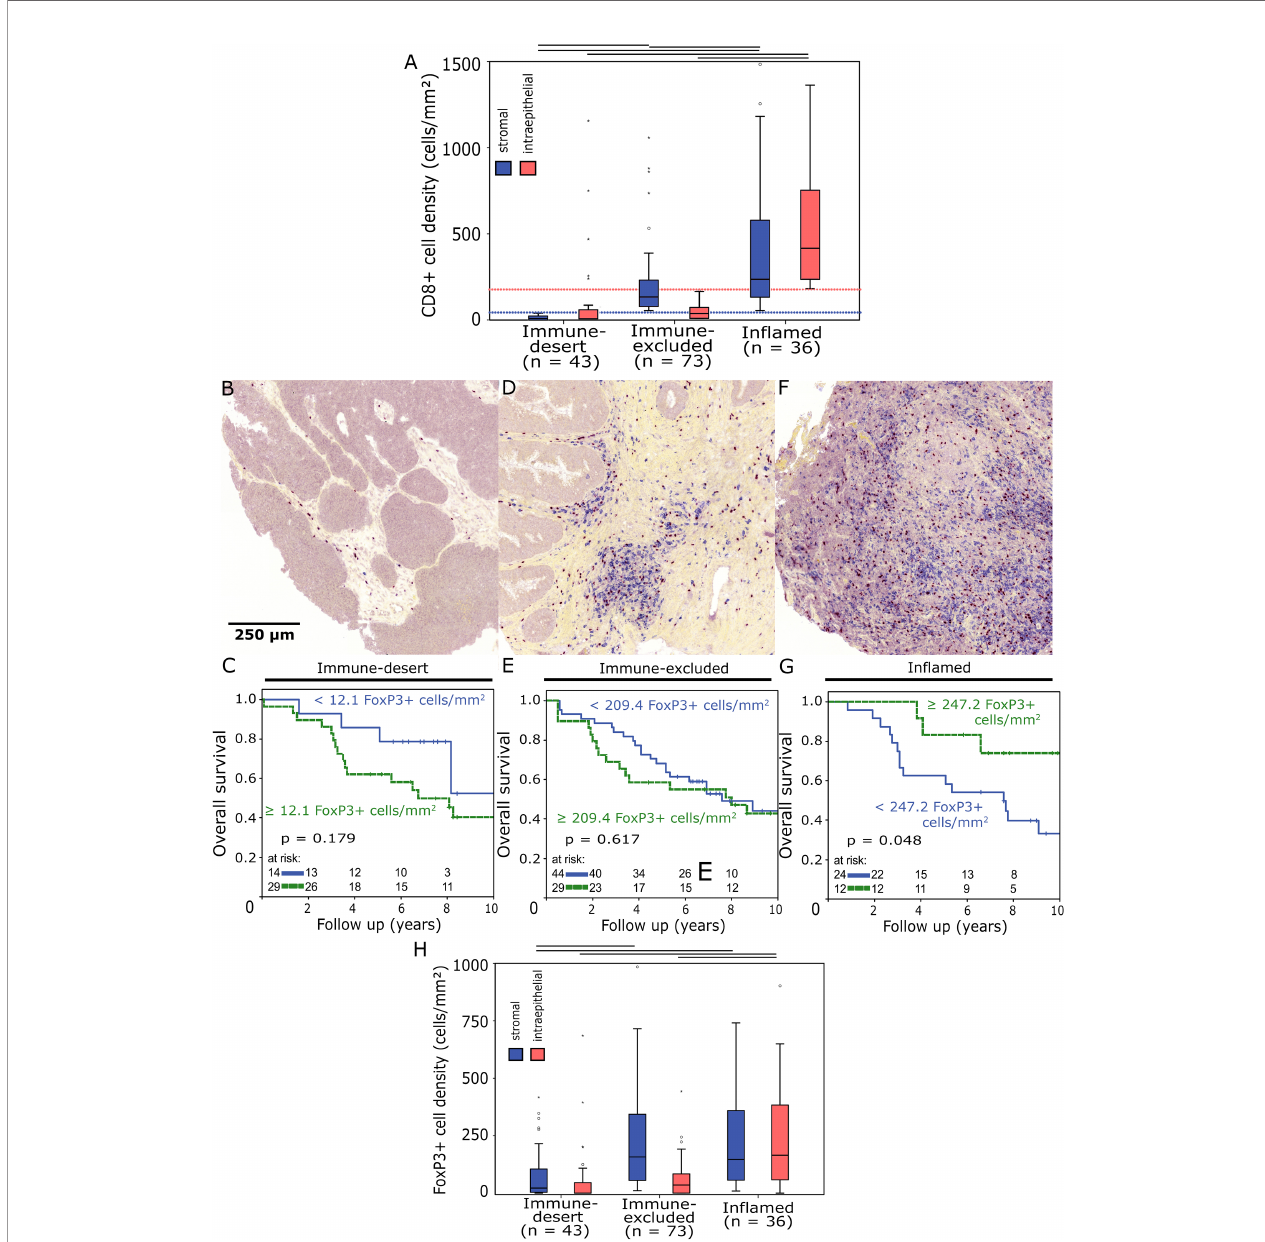
FIGURE 3 | (A) Boxplots of stromal and intraepithelial CD8+ cell density distributions in different immune phenotypes. Outliers are marked with an asterisk (*). Horizontal black bars signify p < 0.05 in Student ’ s t-test. The “ immune-desert ” group was de fi ned by stromal CD8+ cell densities < 40 cells/mm² (dotted blue line), “ in fl amed ” tumours had intraepithelial CD8+ cell densities ≥ 170 cells/mm² (dotted red line). (B, D, F) Representative images of tissue microarray core sections from “ immune-desert ” (B) , “ immune-excluded ” (D) and “ in fl amed ” (F) tumours double stained for FoxP3 (red)/CD8 (blue) (200x magni fi cation). (C, E, G) Overall survival analysed with the Kaplan-Meier method and log-rank test according to stromal FoxP3+ tumour-in fi ltrating T cell densities in “ immune-desert ” (C) , “ immune-excluded ” (E) and “ in fl amed ” (G) tumours. (H) Boxplots of stromal and intraepithelial FoxP3+ cell density distributions in different immune